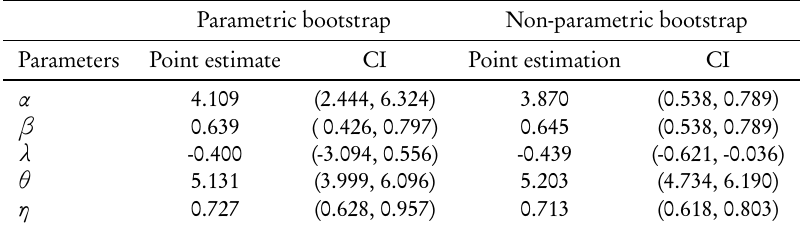
Bootstrap point and interval estimation of the parameters α , β , λ , θ and η for the second data